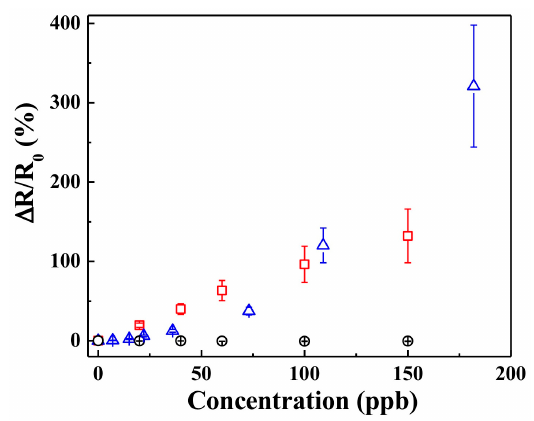
Figure 1. Normalized responses from the pristine polyaniline (PANI) sensors: (red/ □ ) NO 2 , (blue/ ∆ ) O 3 , and (black/ ○ ) SO 2 ; 25 °C; 50% relative humidity (RH). Data points are average of responses from three independent sensors, and error bars represent ±1 standard deviation.